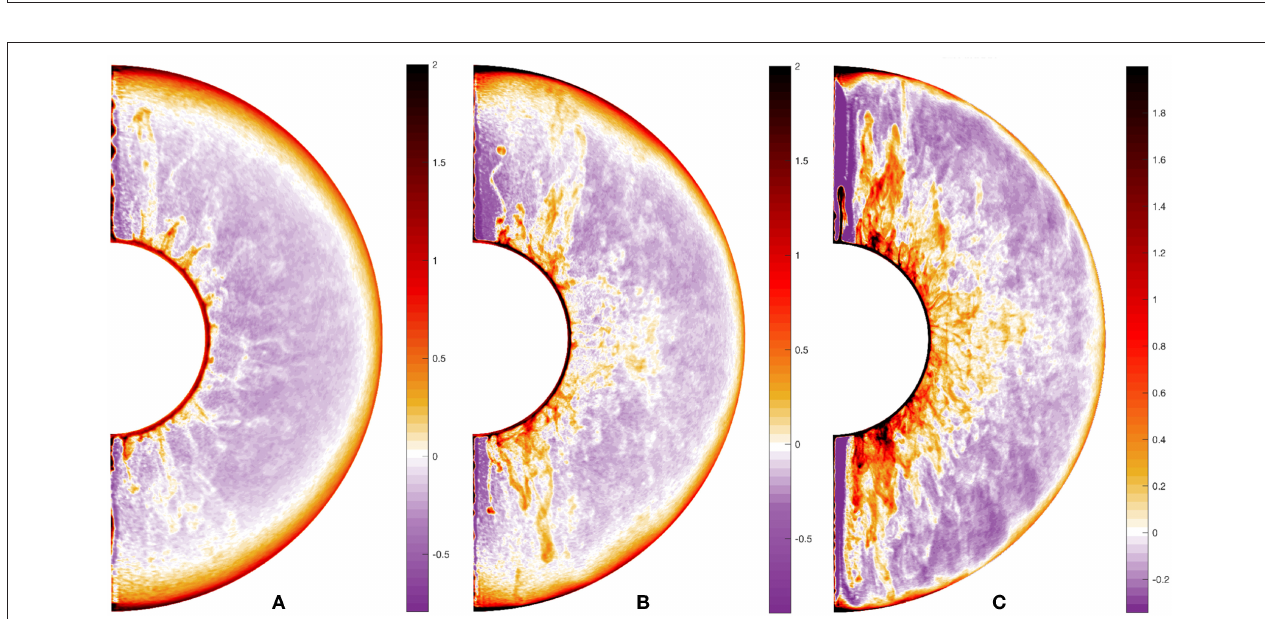
1; A ), 6 ( t 1; B ), and 8 ( t 0.4; C ). Rossby numbers are, respectively: Ro = = =